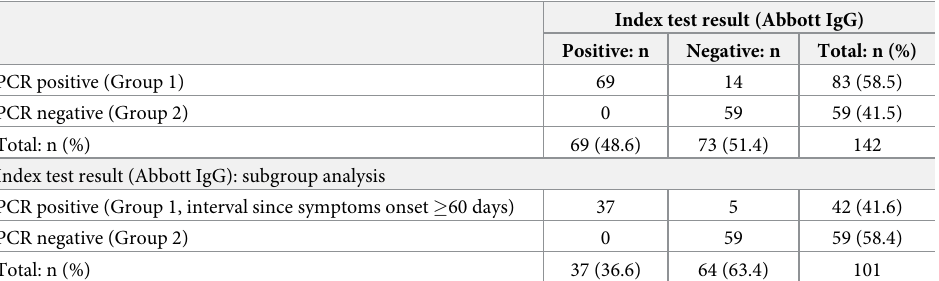
Table 3. Concordance